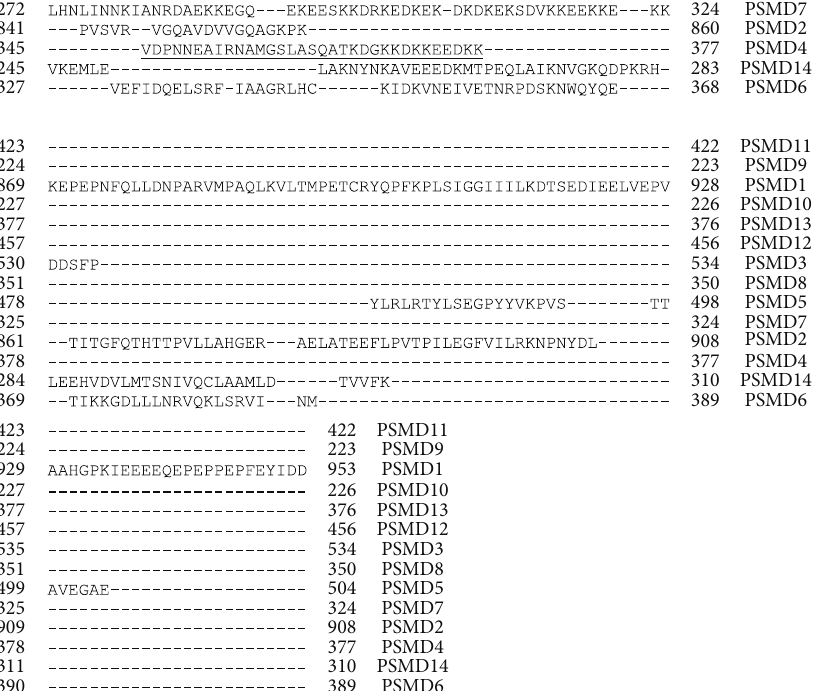
Figure10:AlignmentofhumanPSMDsubunits1–14.ProteinsequencesofthethirteenproteasomePSMDsubunitswerealignedusingClustal W. No residuesare conserved in all PSMD subunits.Naturally occurring variants arehighlighted with grey boxes. Alternatively spliced regions are underlined. Amino acid residue numbers are shown on the left and right of each sequence and the UniProt accession number and gene name of each sequence are shown to the right of each